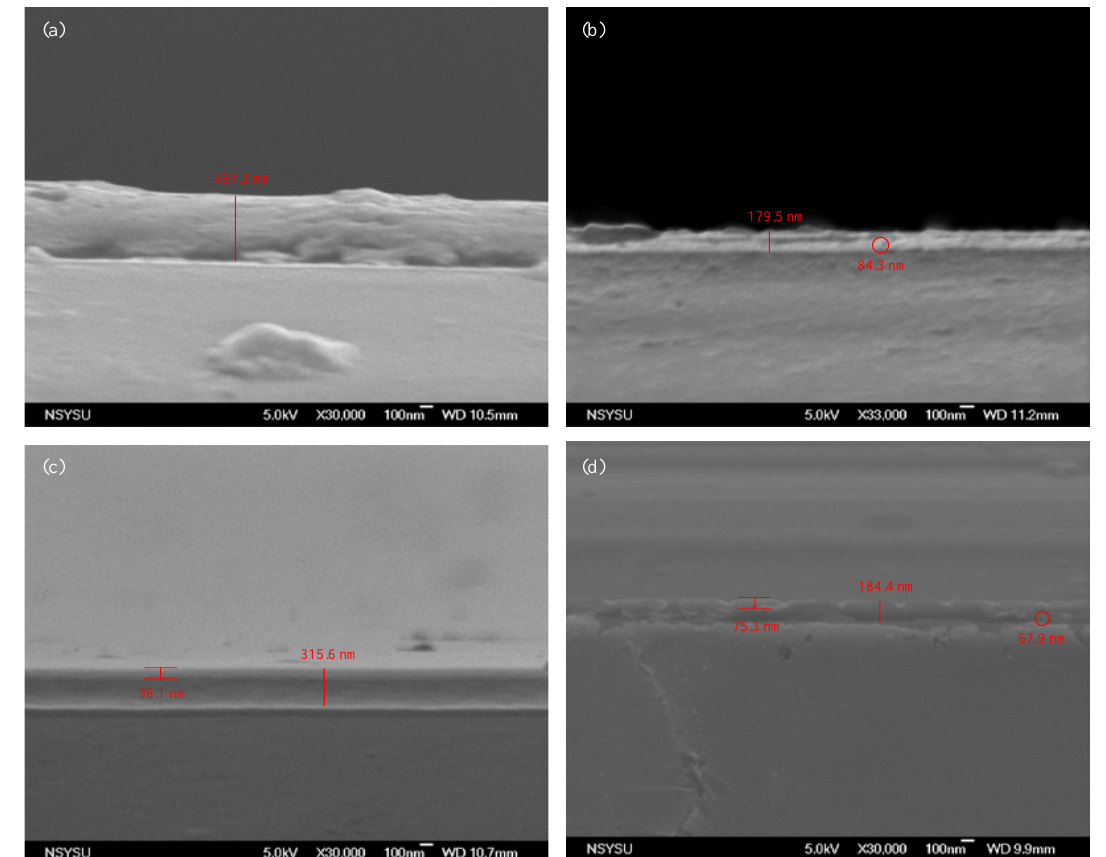
Figure 4. Scanning electron microscopy (SEM) micrograph of the cross sections of ( a ) PEDOT: PSS, ( b ) PEDOT: PSS–sorbitol, ( c ) PEDOT: PSS–maltitol, and ( d ) PEDOT: PSS—sorbitol–maltitol. Table 2. The thicknesses of PEDOT: PSS doped with organic additives.